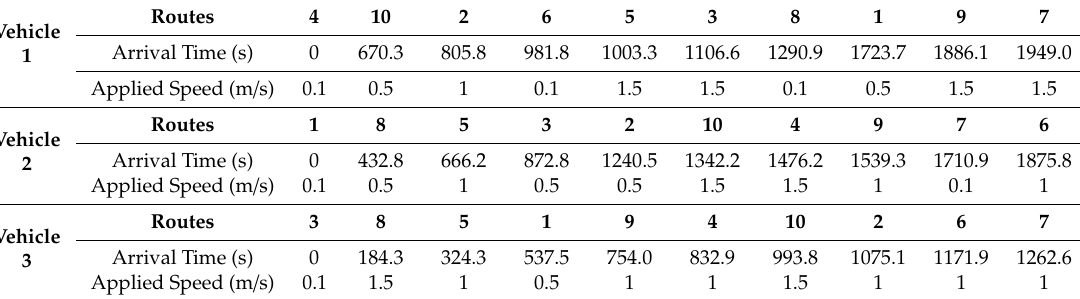
Table 7. Most near-optimal trajectories for t occ > 150